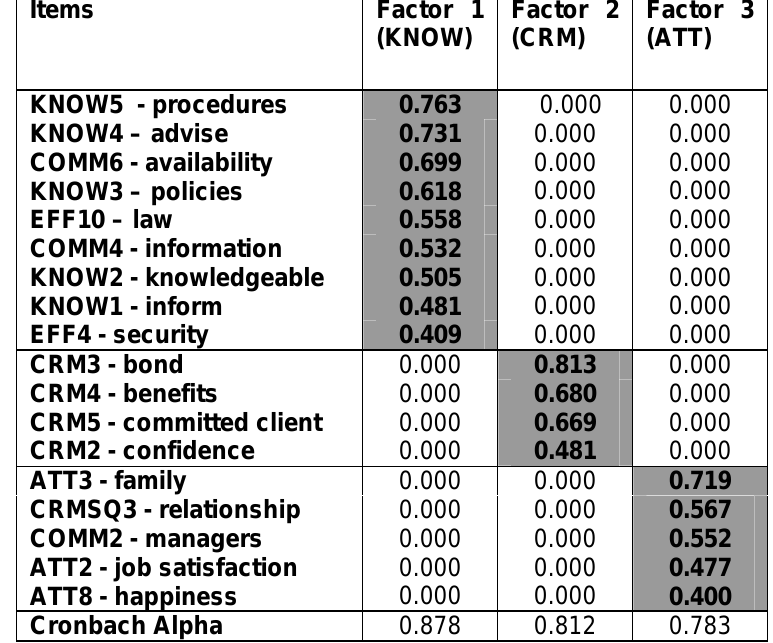
Table 1: Rotated exploratory factor analysis (displaying the results of the variables attitude , knowledgeability and CRM